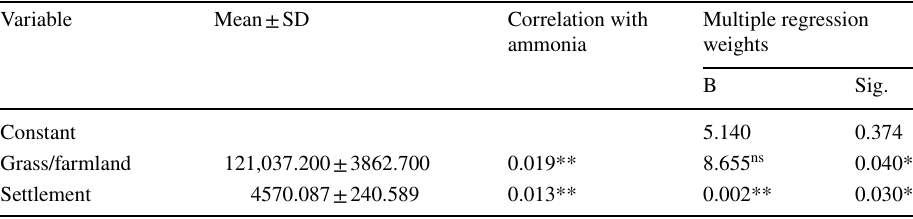
multiple linear regression analyses between ammonia and LULCC